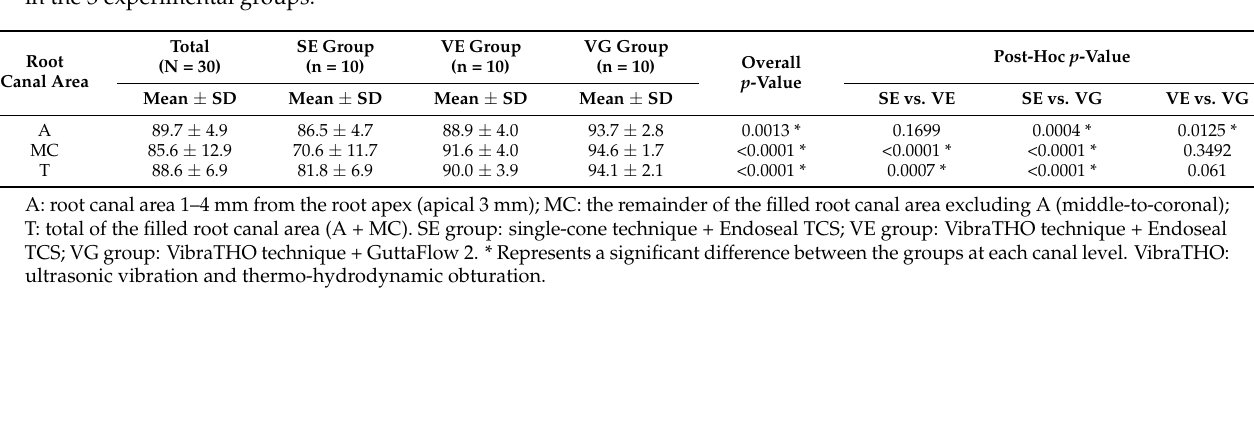
Table 2. Mean and standard deviation (SD) values of the percentage volume of gutta-percha + sealer at different canal levels in the 3 experimental